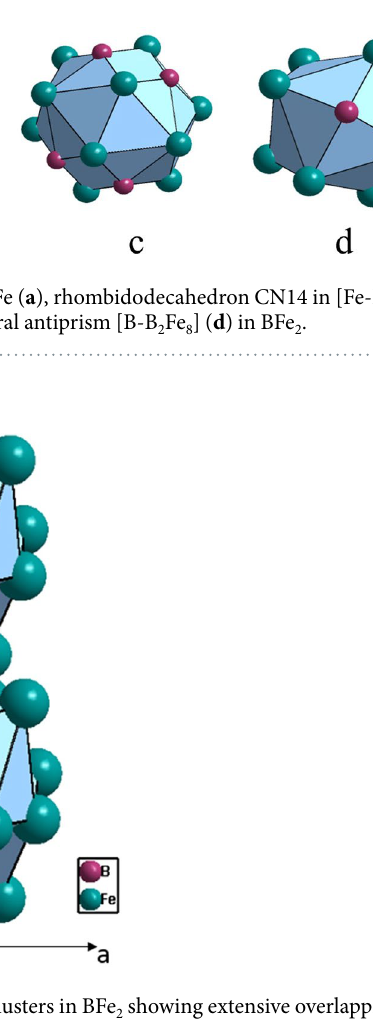
Figure 2. Inter-connection of B-centered [B-B 2 Fe 8 ] clusters in BFe 2 showing extensive